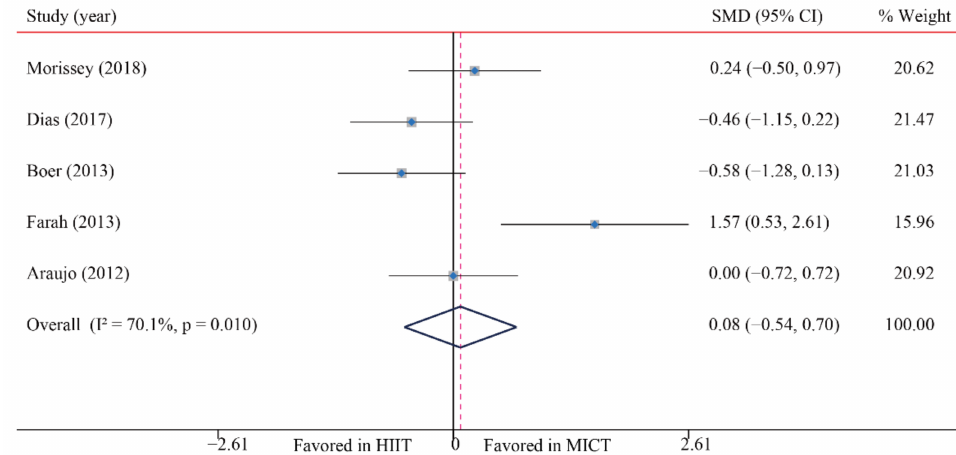
Figure 16. Effect of HIIT versus MICT on